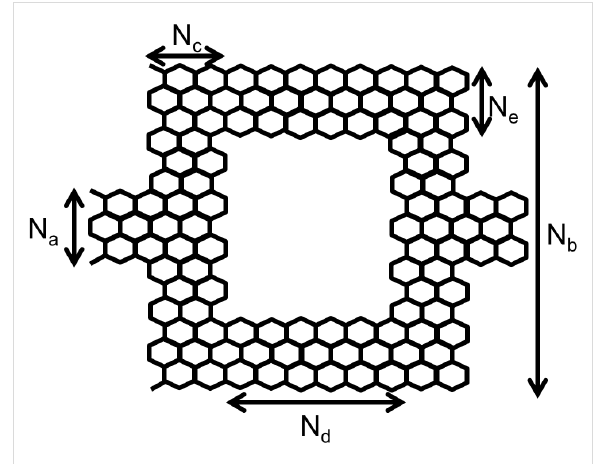
Figure 1: Graphene nanoribbon MZI structure (zigzag type).